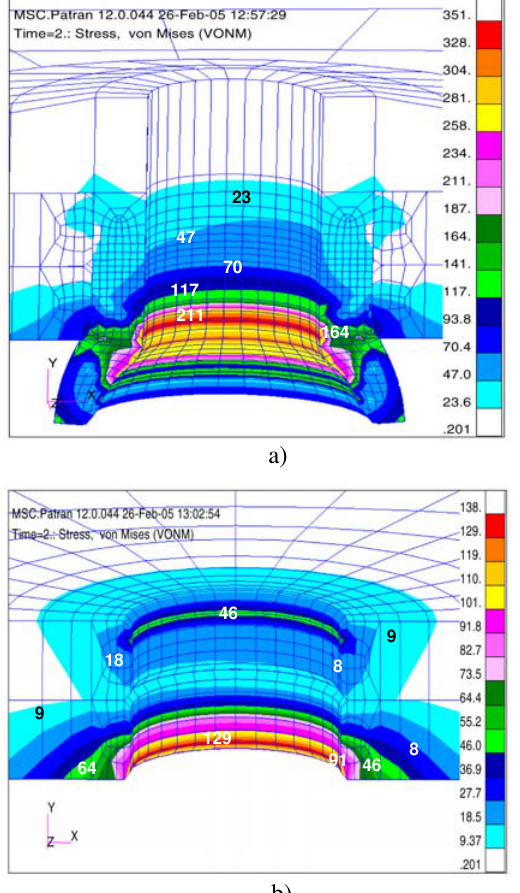
Fig 8. Residual Von Mises stress distribution for sheets (a) and for rivet (b) after riveting process